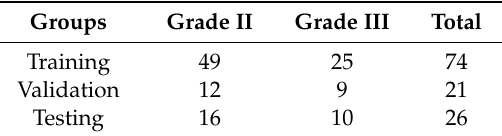
Table 3. Training, validation, and testing statistics.